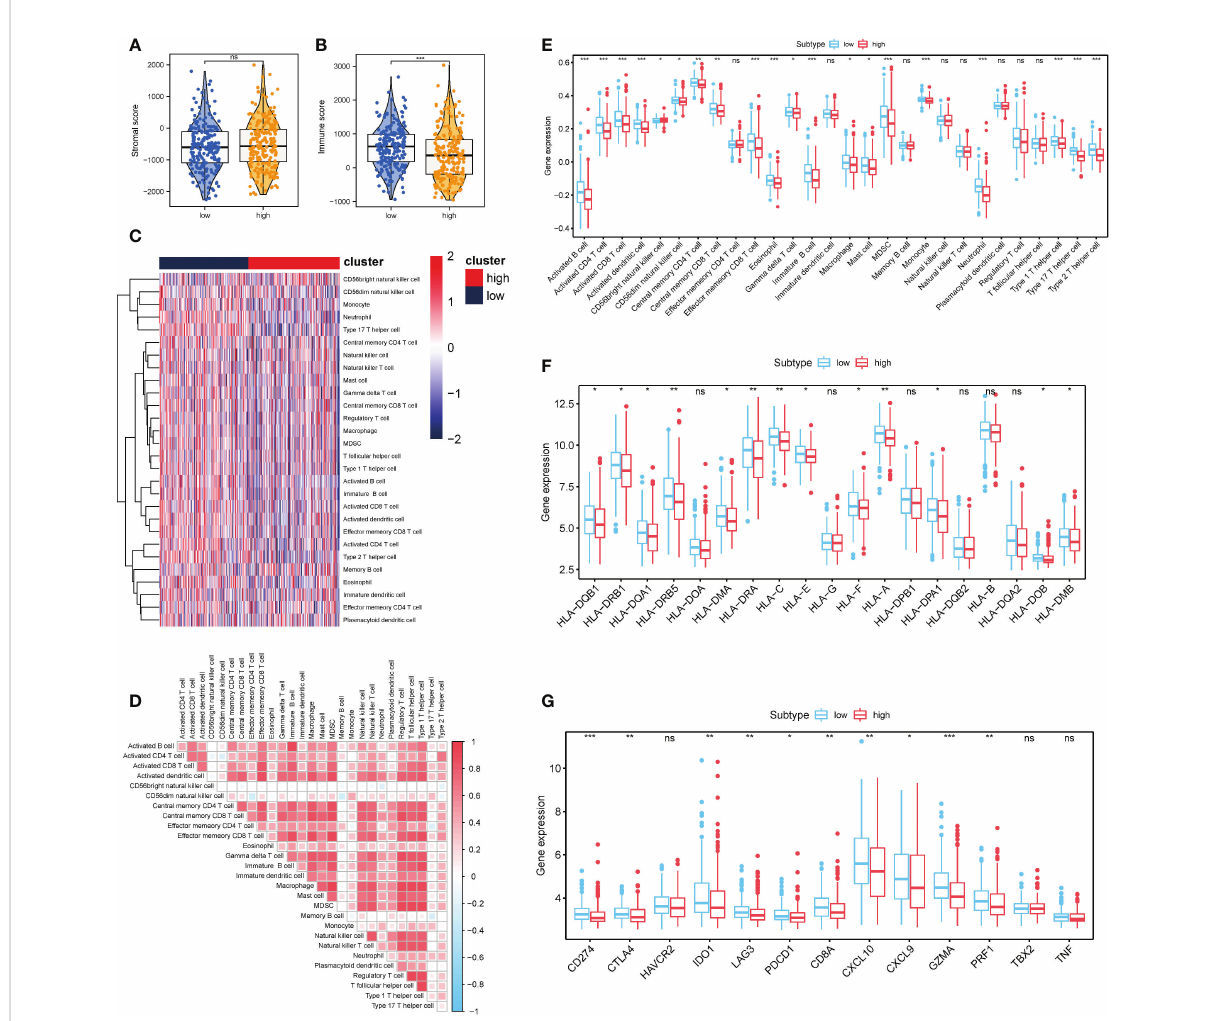
FIGURE 7 Correlation between necrosis risk scores and the in fi ltrates of different immunocytes (A, B) Immune score and stromal score between the low- and high- risk groups; (C) Heat map showing the invasion degrees of 28 different immune cells in TCGA and GEO database; (D) Association heat map showing the association between various levels of immunocyte in fi ltration. (E) Differential analysis of 28 different immunocyte in fi ltration levels between the two groups; (F) Analysis of differences in the expression of multiple members of the HLA family between the high- and low-risk related subgroups; (G) Differential expression analysis of multiple immunotherapy-related targets between the high- and low-risk related groups. * P < 0.05, ** P < 0.01, *** P < 0.001. "ns" represents "no signi fi